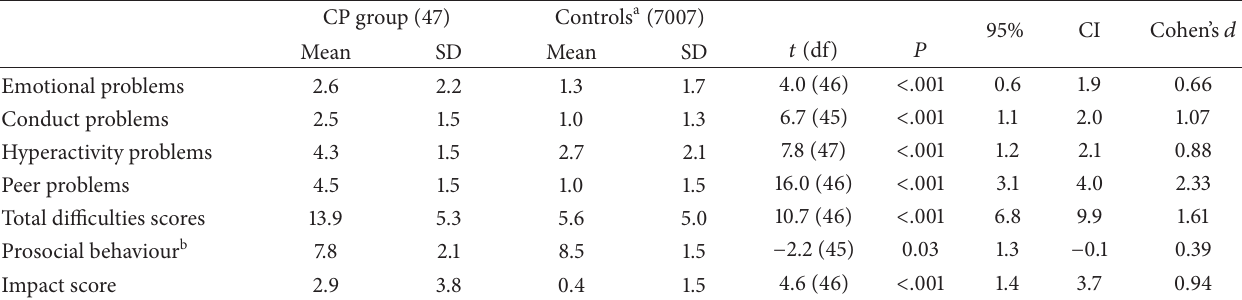
Table 2: Mental health for children with cerebral palsy (CP) using mean scores of the Strengths and Difficulties Questionnaire compared with controls.